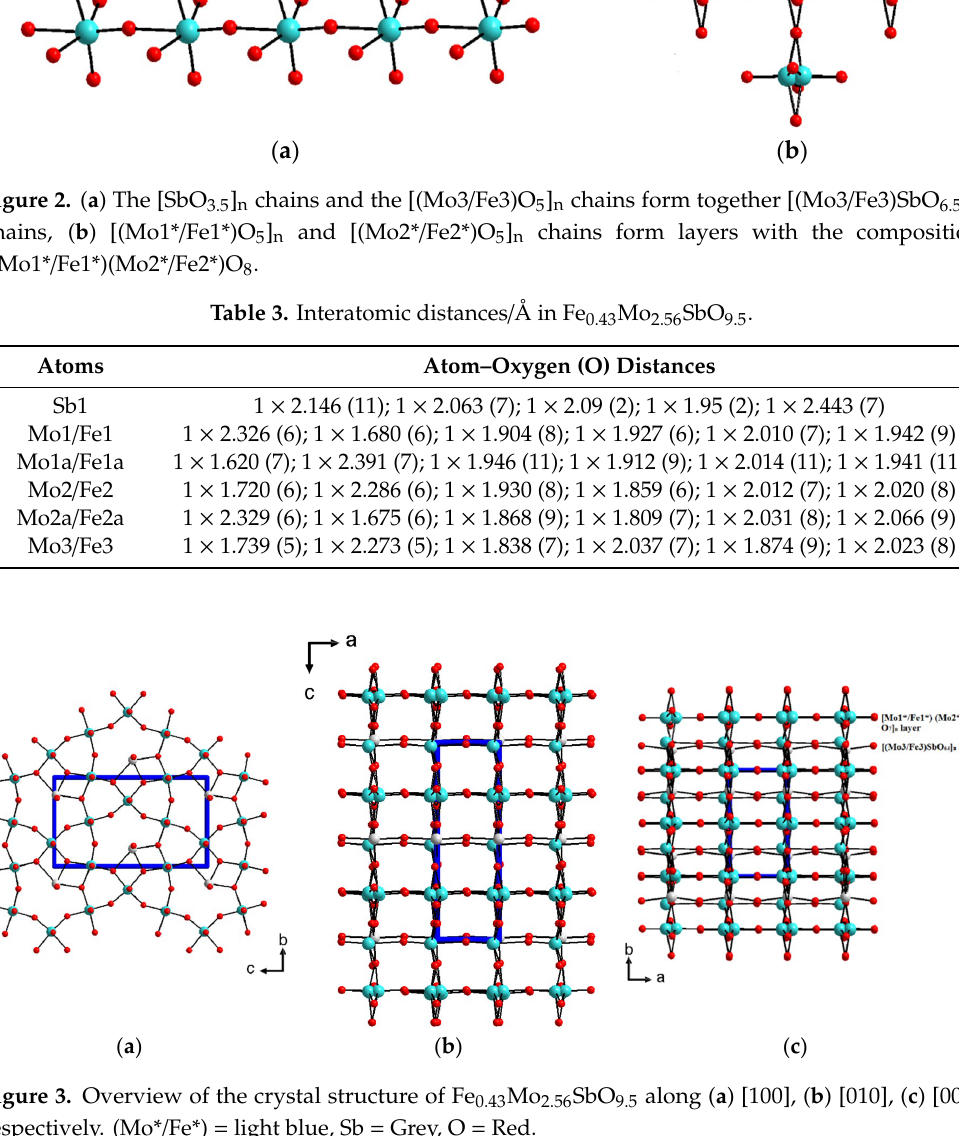
Figure 3. Overview of the crystal structure of Fe 0.43 Mo 2.56 SbO 9.5 along ( a ) [100], ( b ) [010], ( c ) [001] respectively.(Mo*/Fe*) = light blue, Sb = Grey, O = Red. Table 3. Interatomic distances/Å in Fe 0.43 Mo 2.56 SbO 9.5.